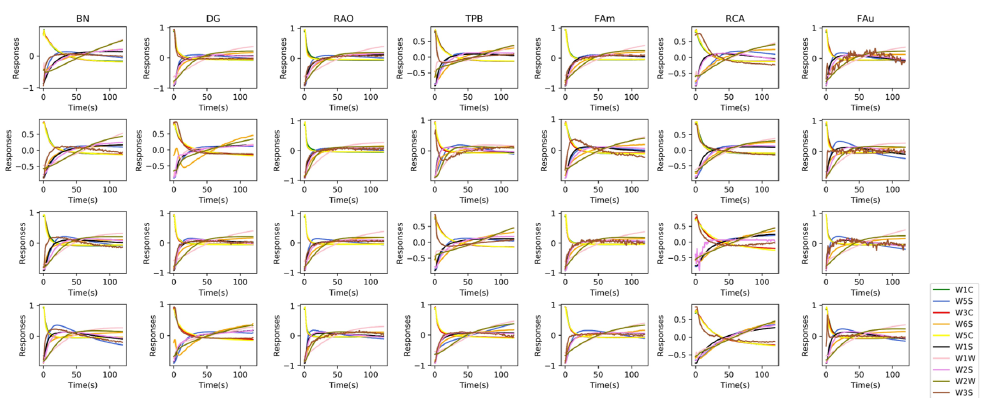
Figure 5. Centralized sensing responses of seven types of Chinese herbal medicines (Betel Nut (BN), Dried Ginger (DG), Rhizoma Alpiniae Officinarum (RAO), Tree Peony Bark (TPB), Fructus Amomi (FAm), Rhioxma Curcumae Aeruginosae (RCA), Fructus Aurantii (FAu)). We randomly selected four response samples of each medicine. All response data were implemented by centralized normalization.